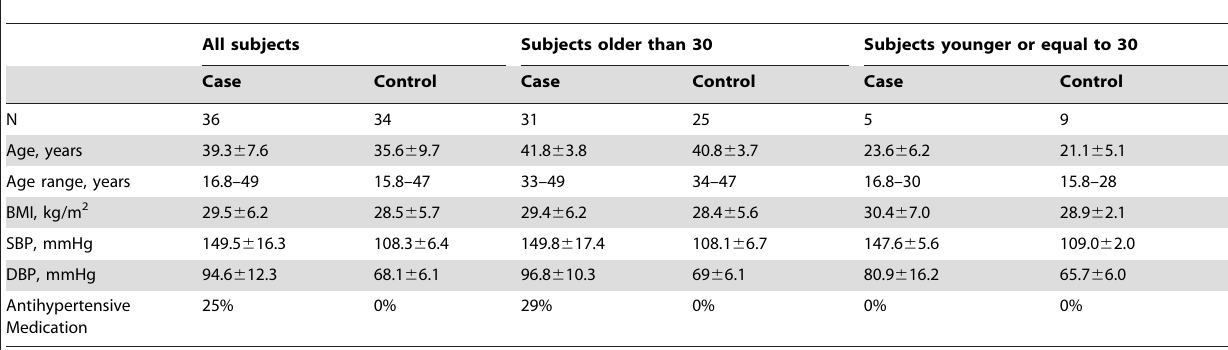
Table 5. General characteristics of the subjects in PA cohort (2nd replication panel).